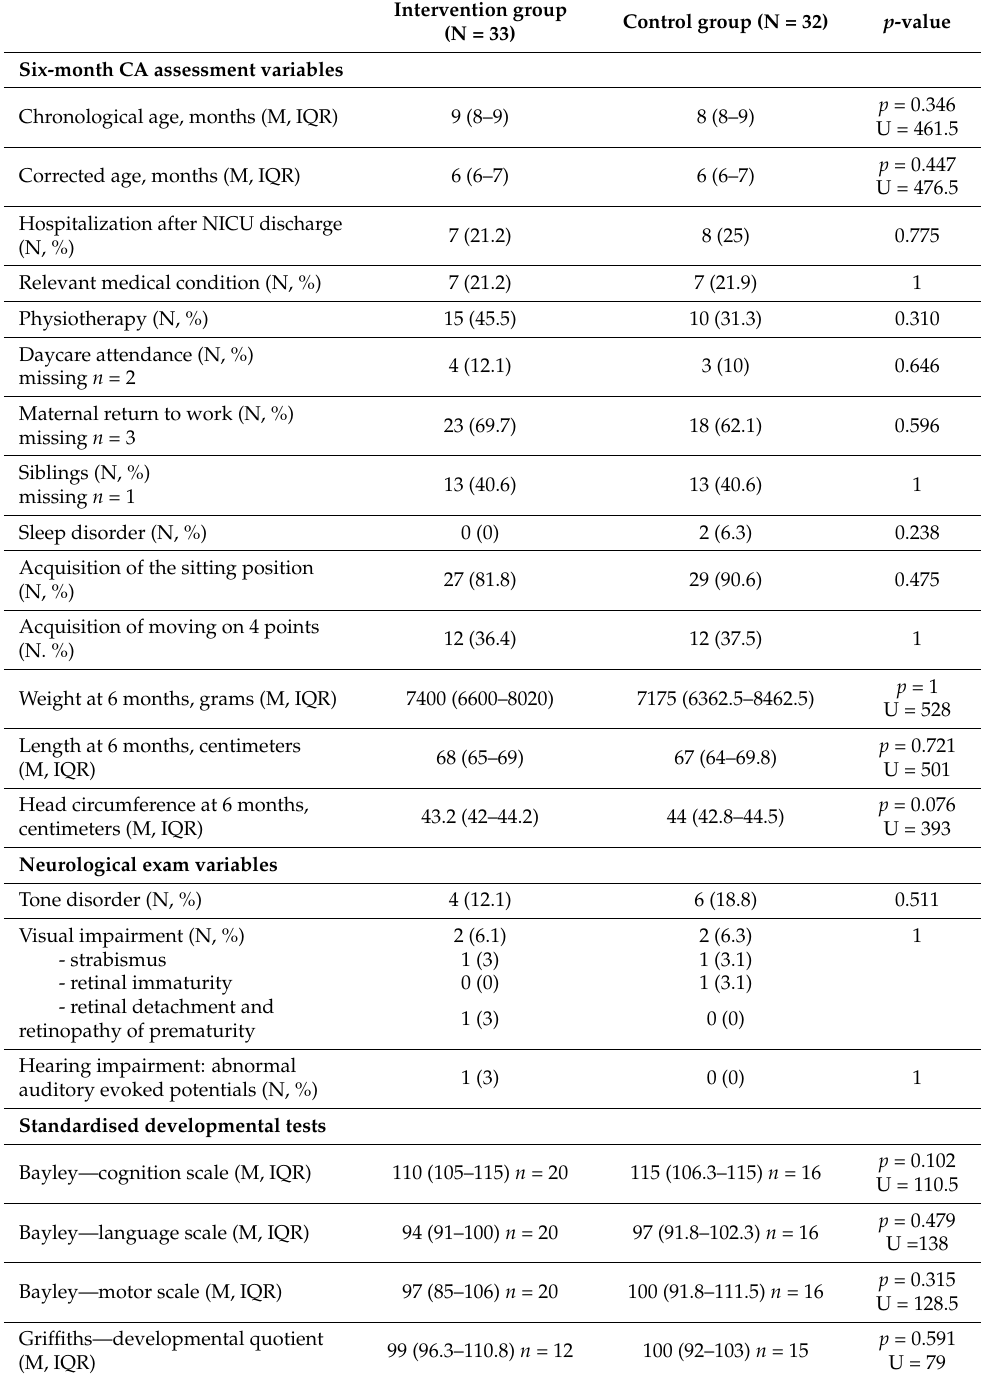
Table 2. Six-month CA assessment variables, neurological exam variables and standardised develop- mental